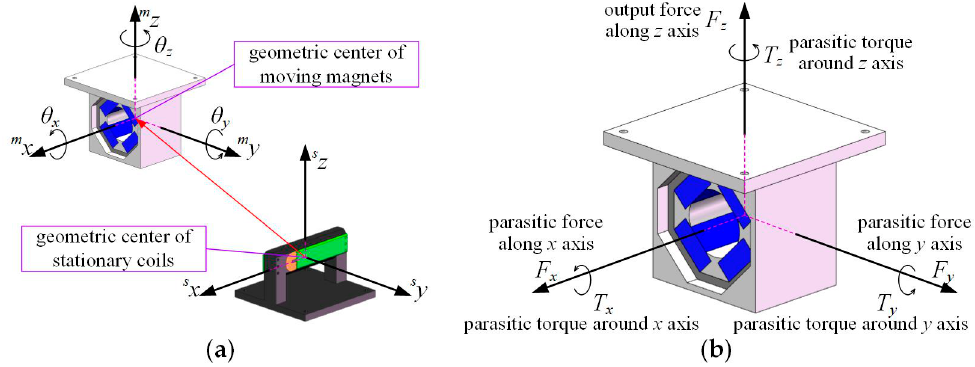
Figure 4. Motion, force and torque of the HMF-VCA. ( a ) Six-degree-of-freedom motion of the HMF-VCA. ( b ) The force and torque acting on the mover of the HMF-VCA.